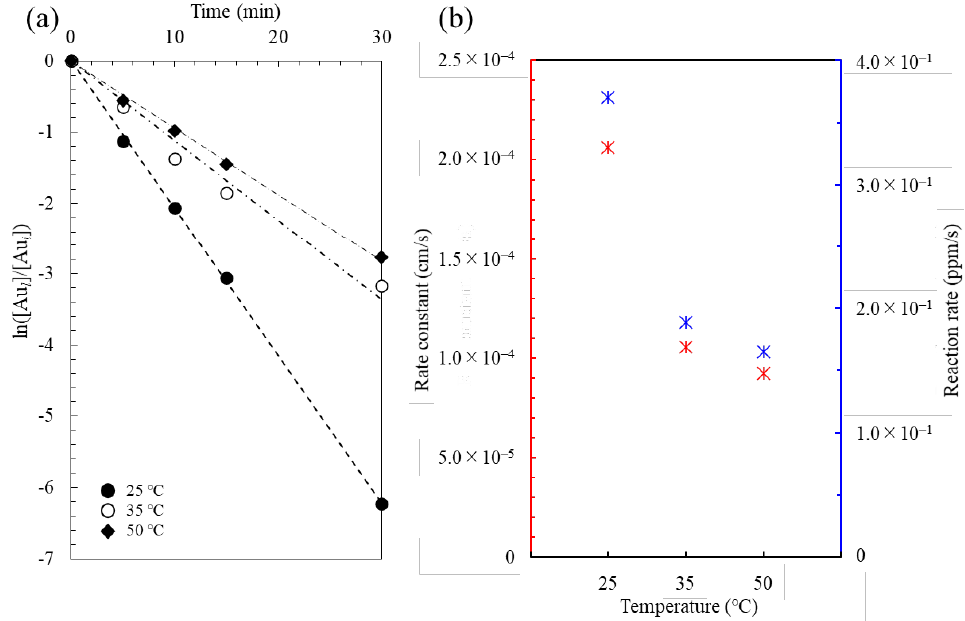
Figure 5. ( a ) The effects of temperature on recovery of Au ions, and ( b ) the plot of rate constant/rate vs temperature for the cementation reaction by galvanic interaction of Al and AC in ammonium thiosulfate system (Note that reaction rate has a minus value. Table 5. Summary of rate constant for the cementation of Au as a function of temperature (base